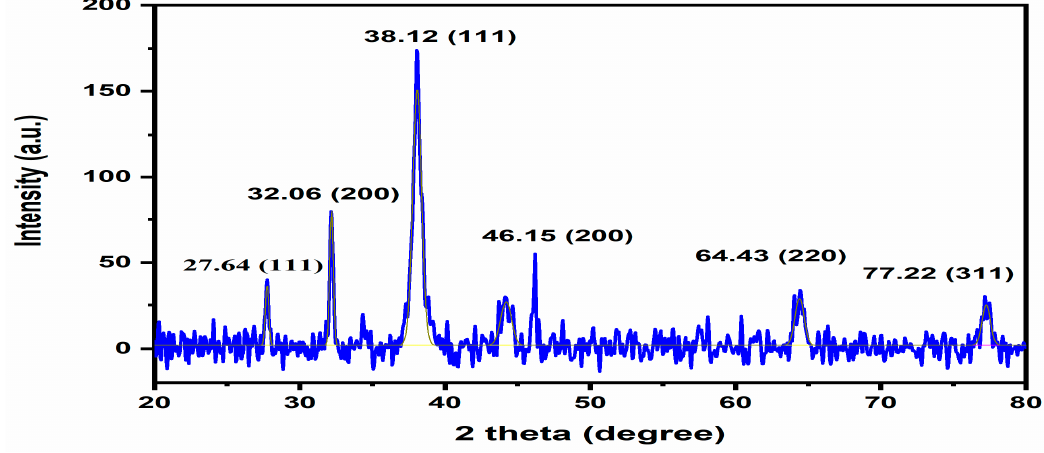
Figure 3. XRD pattern of T. couneifolia AgNPs.